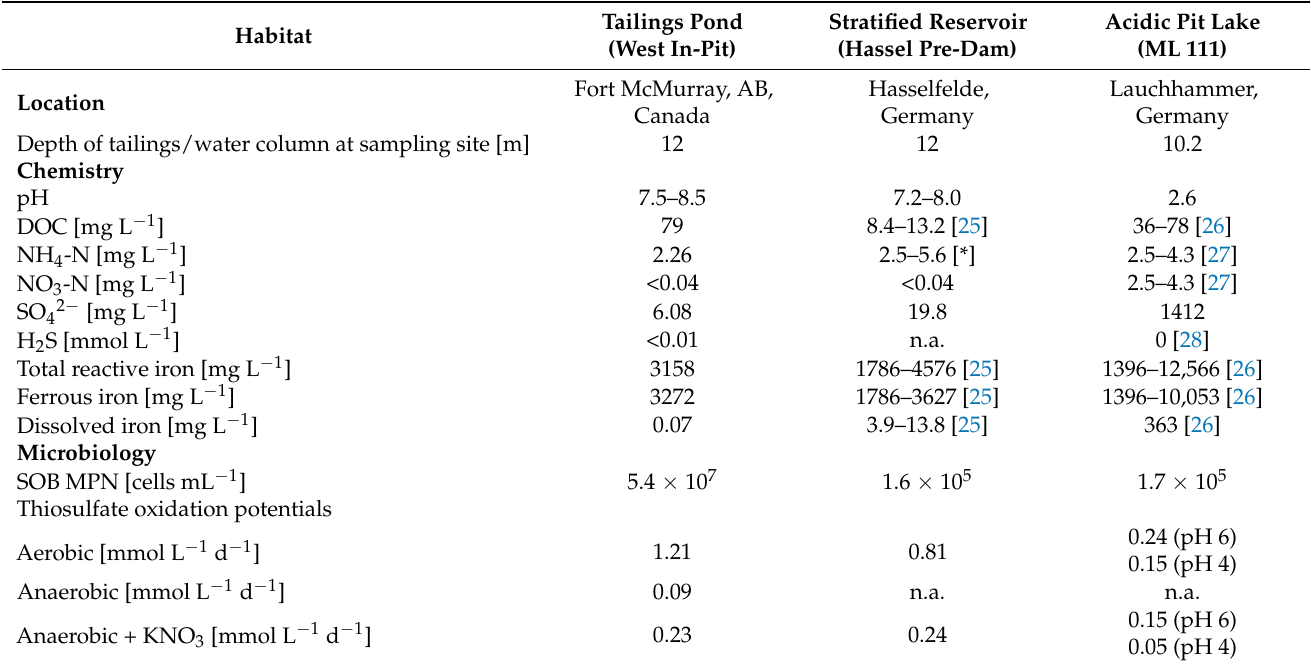
Table 1. Biogeochemical characteristics of anoxic sediments from anthropogenic aquatic habitats. Habitat